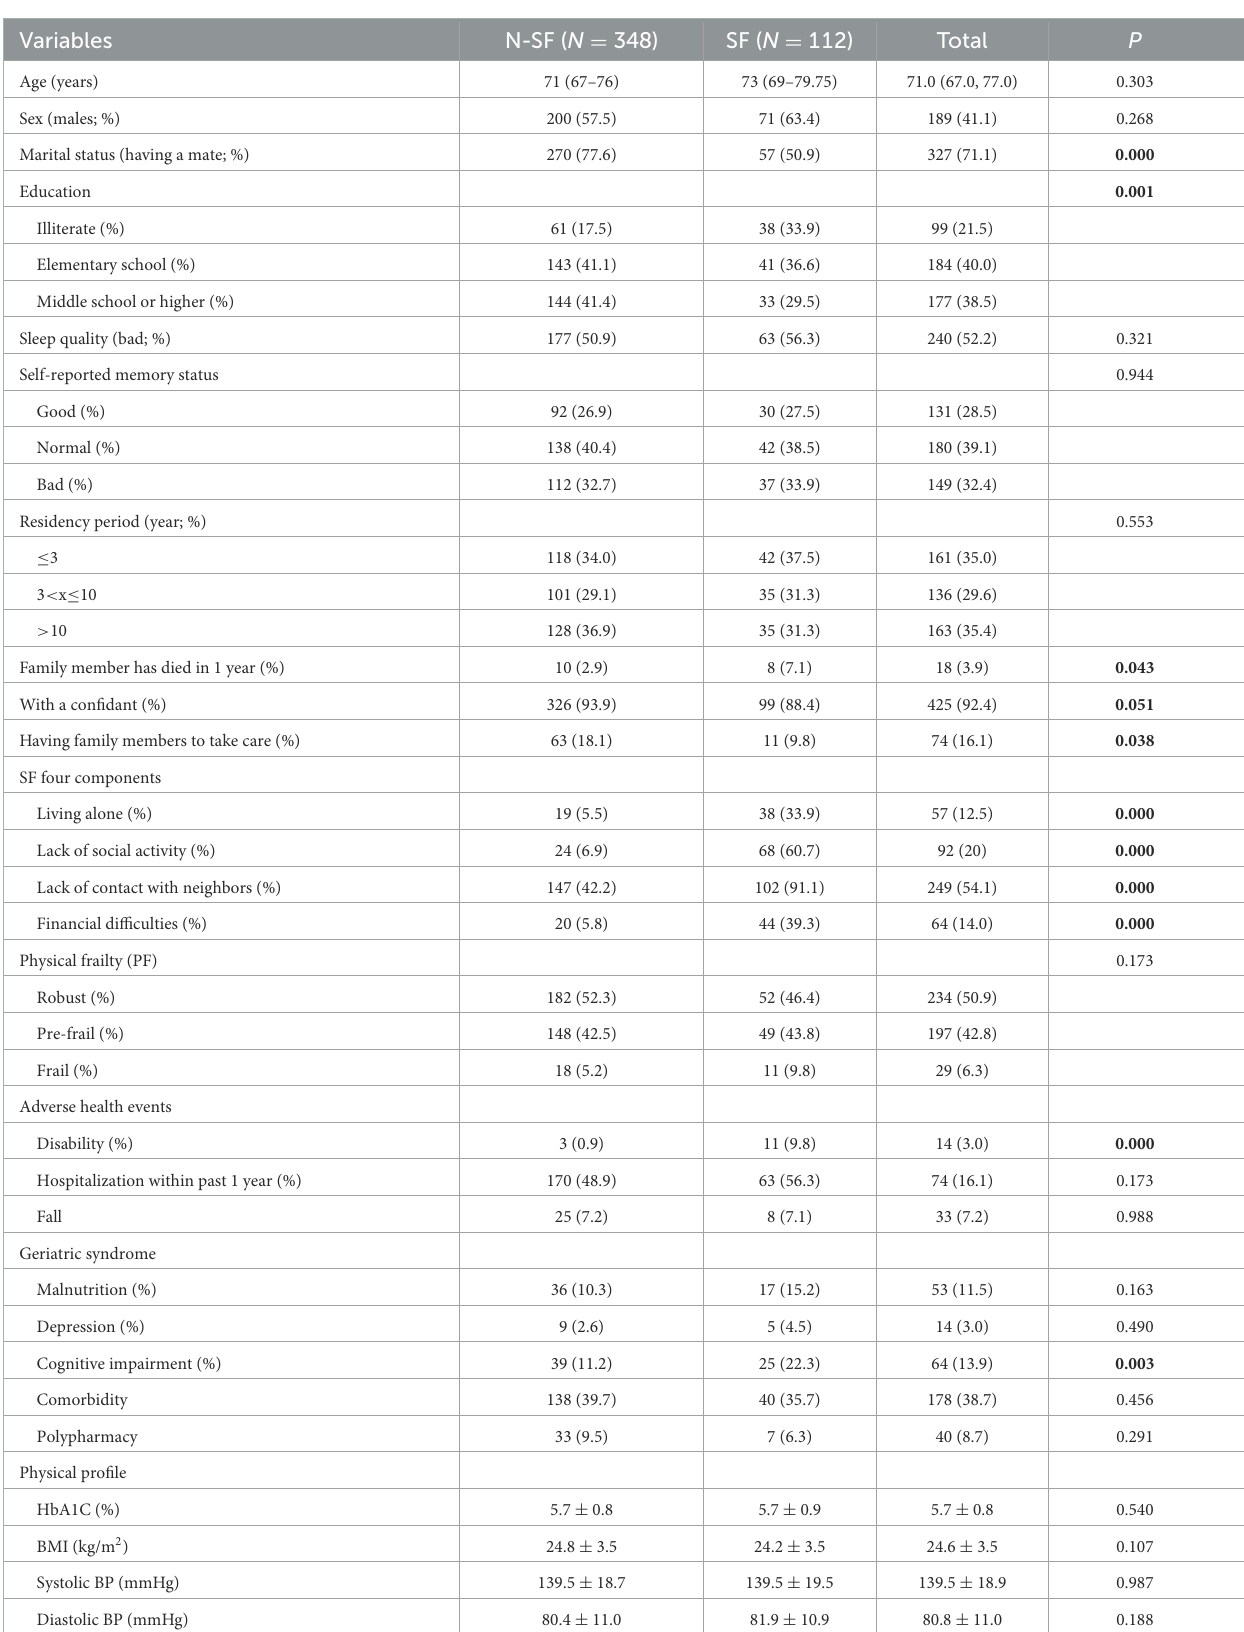
TABLE 1 Demographic characteristics of SF in wave 1 ( N =